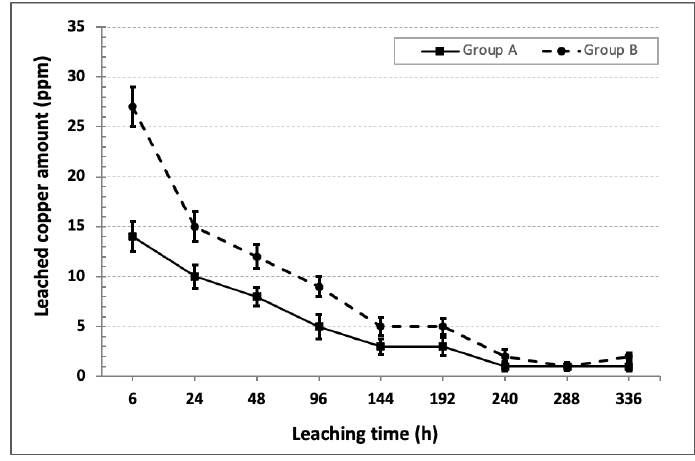
Figure 5. Element amount leached out from radiata pine wood samples.